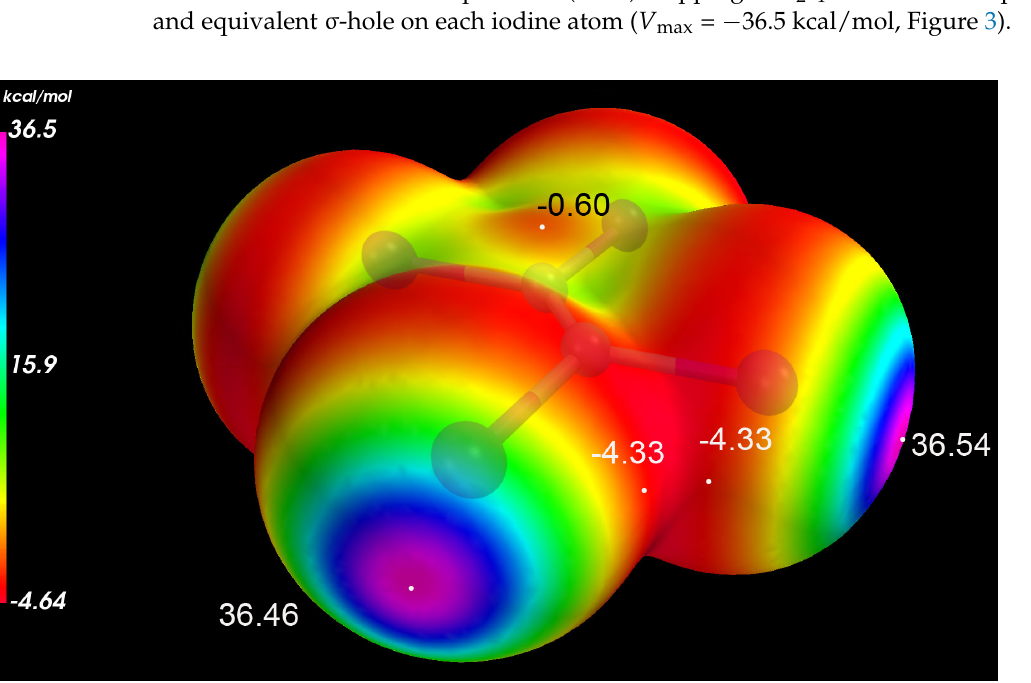
Figure 3. Molecular electrostatic potential (MEP) maps for an isolated molecule of C 2 I 4 (0.002 e/A 3 electron density isosurface).